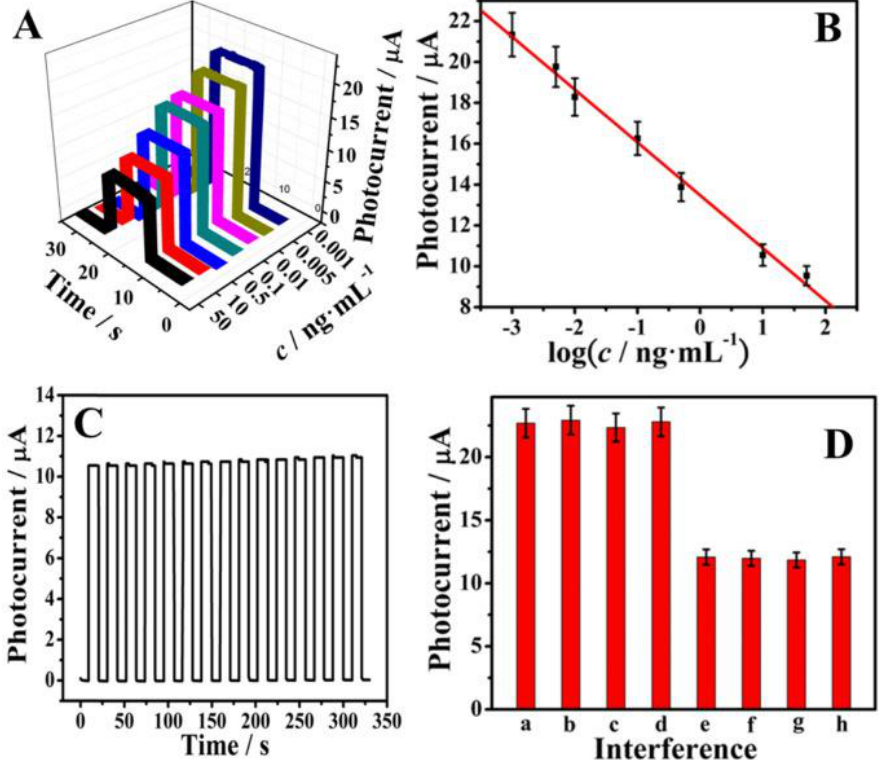
Figure 2. ( A ) Photocurrent response and ( B ) the logarithmic calibration curve for the sensor to detect cTnI in a concentration-dependent manner. ( C ) Photocurrent response of the sensor under 15 on/off illumination cycles for 320 s, concentration of cTnI = 10 ng/mL. ( D ) Selectivity of the sensor to detect cTnI: (a) Blank, (b) Blank + 100 ng/mL carcinoembryonic antigen, (c) Blank + 100 ng/mL squamous cell carcinoma antigen, (d) Blank + 100 ng/mL prostate-specific antigen, (e) 1 ng/mL cTnI, (f) 1 ng/mL cTnI + 100 ng/mL carcinoembryonic antigen, (g) 1 ng/mL cTnI + 100 ng/mL squamous cell carcinoma antigen, and (h) 1 ng/mL cTnI + 100 ng/mL prostate-specific antigen. Reprinted with permission from reference [44], copyright 2018